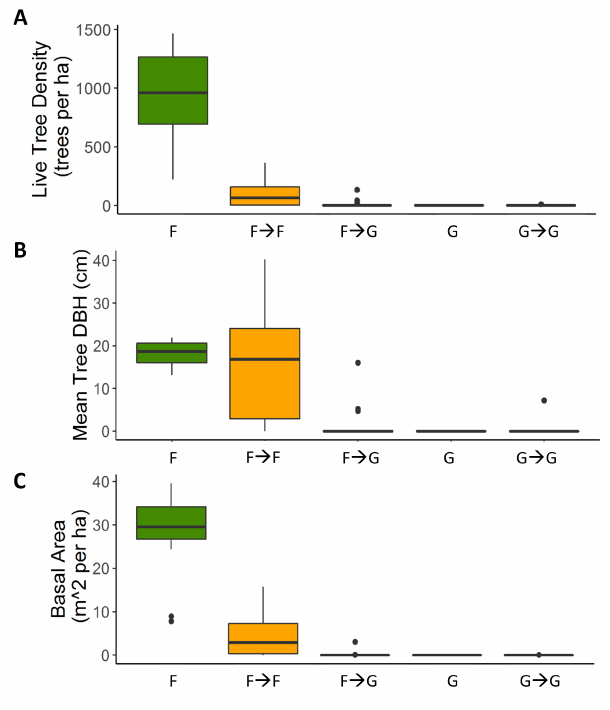
Fig. 2 . Mean live ponderosa pine tree density (A), mean live ponderosa pine tree diameter at breast height (B), and live ponderosa pine basal area (C) across unburned forest sites (F), forest sites that burned at low severity and are expected to resemble unburned forest (F->F), forest sites that burned at high severity and are expected to resemble unburned grassland sites (F->G), unburned grassland sites (G), and grassland sites that burned and are expected to resemble unburned grassland (G->G).